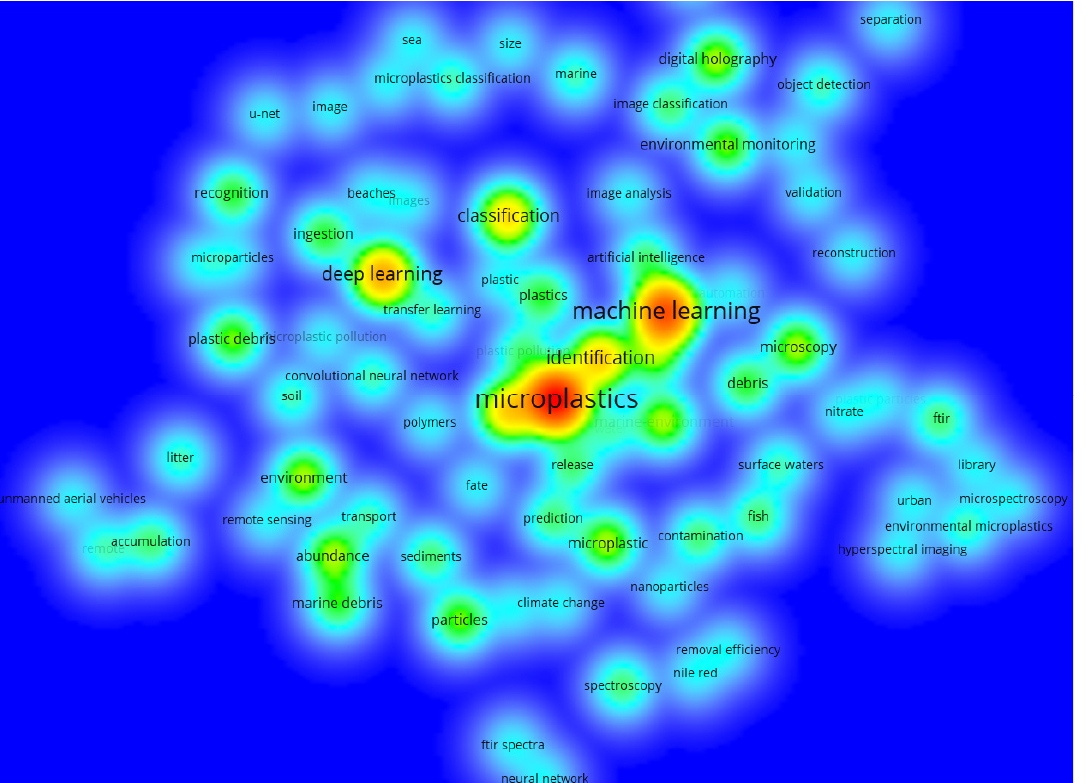
Figure 6. Themes of all 69 documents (visualized with VOSviewer).